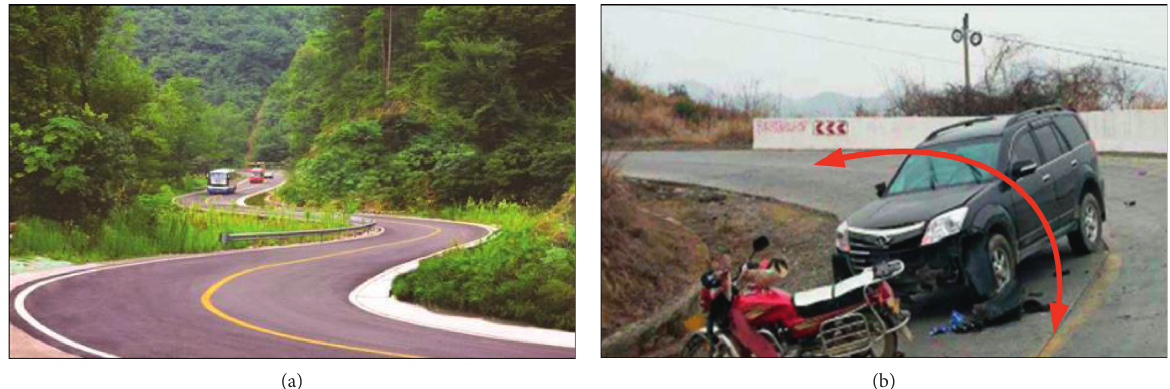
Figure 1: Driving environment of two-lane rural